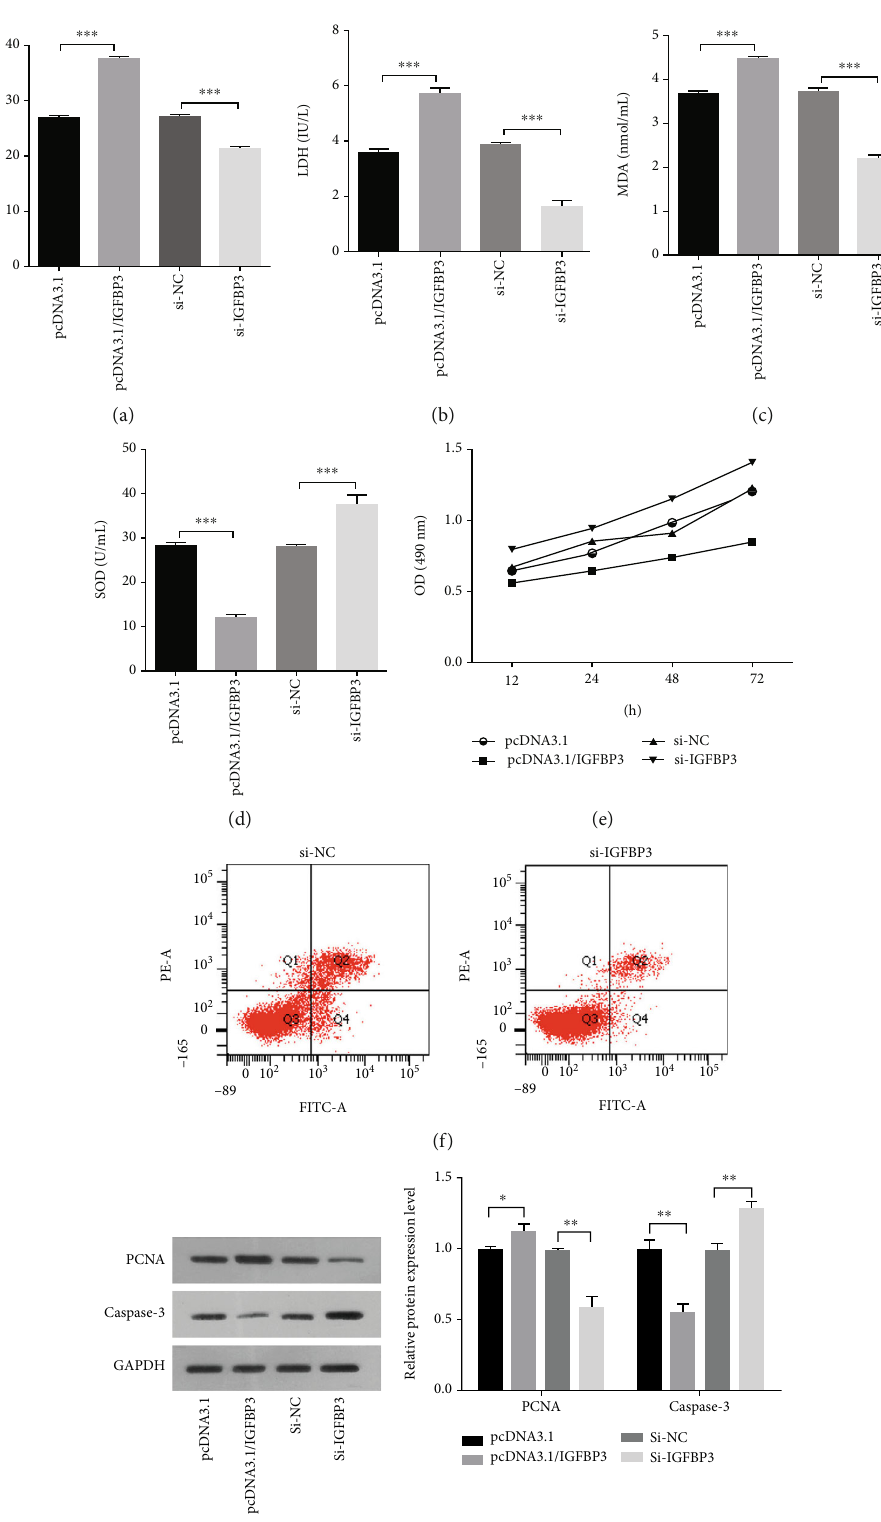
Figure 6: IGFBP3promotedoxidativestressandinhibitedproliferationoftenocytes.(a – d)ELISAwasusedtodetectthelevelsofCK,LDH,MDA,and SOD in the pcDNA3.1 group, pcDNA3.1/IGFBP3 group, si-NC group, and si-IGFBP3 group. (e) MTT was used to detect the activity of tendon cells in the pcDNA3.1 group, pcDNA3.1/IGFBP3 group, si-NC group, and si-IGFBP3 group. (f) FCM was performed to detect the apoptosis of tenocytes. (g) The expression of apoptosis-related proteins was detected by Western blot in the pcDNA3.1 group, pcDNA3.1/IGFBP3 group, si-NC group, and si- IGFBP3 group ( ∗ P < 0 : 05 , ∗∗ P < 0 : 01 , and ∗∗∗ P < 0 : 001